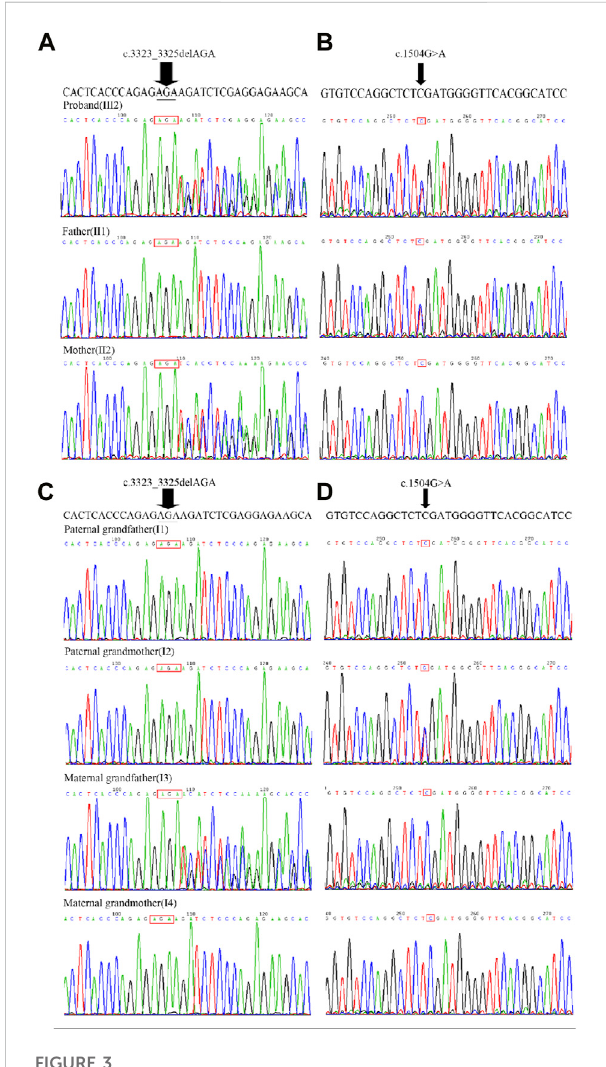
FIGURE 3 Sanger sequencing chromatograms of FLT4, c.3323_3325del and c.1504G > A. (A) The recurrent variant c.3323_3325del (indicated by an arrow) was detected in the proband (III2), unaffected mother (II2), but not detected in unaffected father (II1). (B) The missense variant c.1504G > A (indicated by an arrow) was detected in the proband (III2), unaffected father (II1) but not detected in unaffected mother(II2). (C) Therecurrentvariantc.3323_3325del(indicatedbyan arrow) was detected in the unaffected maternal grandfather (I3) but not detected in unaffected maternal grandmother (I4), unaffected paternal grandmother (I2) and unaffected paternal grandfather (I1). (D) The missense variant c.1504G > A was detected in the unaffected paternal grandmother (I2), but not detected in unaffected paternal grandfather (I1), unaffected maternal grandmother (I4)and unaffected maternal grandfather